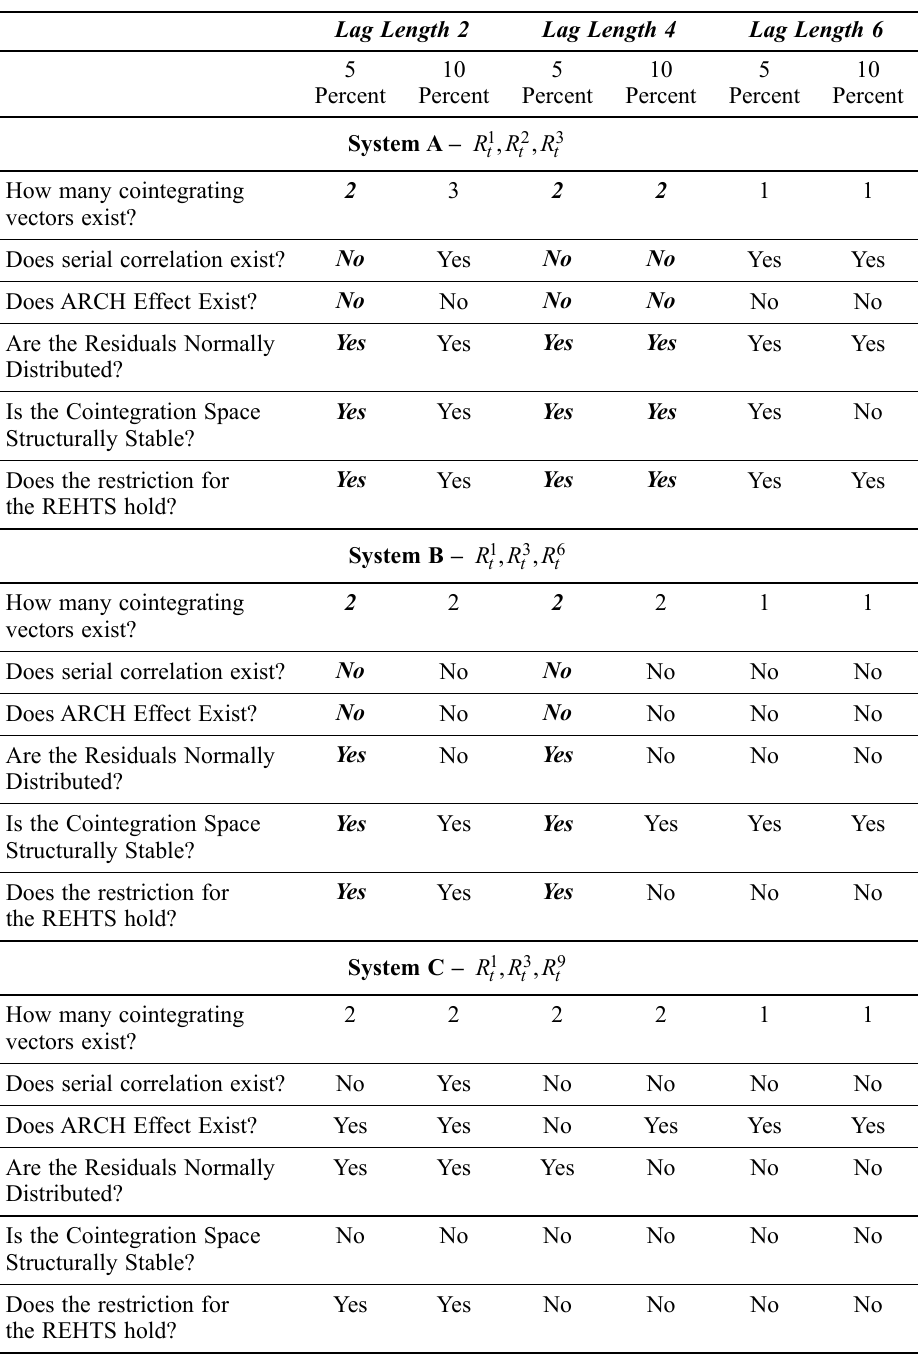
Table 1. Decisions based on cointegration and diagnostic tests